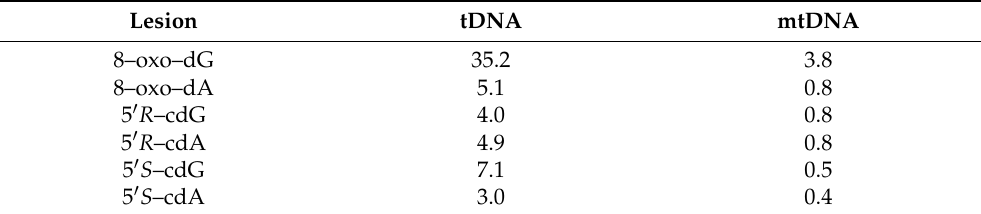
Figure 5. γ –Irradiation induced formation of 8–oxo–dG, 8–oxo–dA, 5 (cid:48) R –cdG, 5 (cid:48) R –cdA, 5 (cid:48) S –cdG, and 5 (cid:48) S –cdA in ( A ) tDNA and ( B ) mtDNA samples; the values represent the mean ± SD of n = 3 independent experiments. Table 3. The levels of 8–oxo–dG, 8–oxo–dA, 5 (cid:48) R –cdG, 5 (cid:48) R –cdA, 5 (cid:48) S –cdG, and 5 (cid:48) S –cdA (Lesions/10 7 nu/Gy)